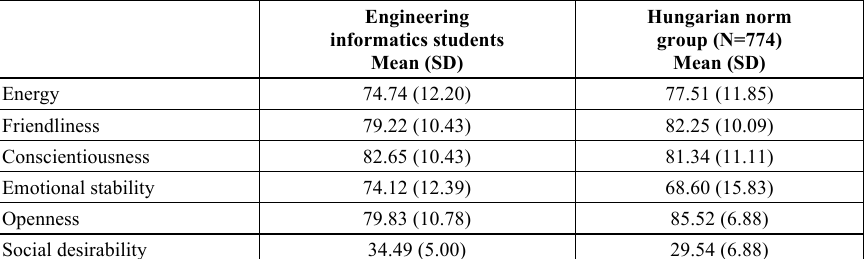
Table 3. Means and standard deviations (SD) of Engineering Informatics students in five personality factors and social desirability scale compared with the Hungarian norm group (raw scores) Engineering informatics